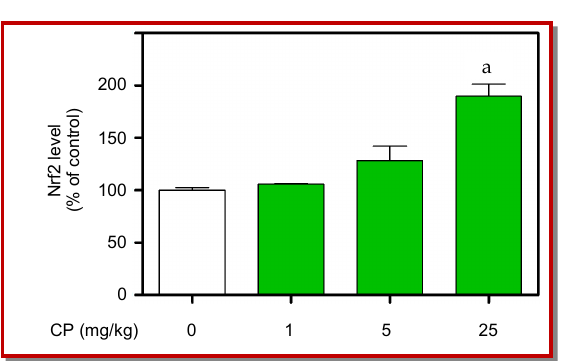
Figure 4: Effects of Cicadidae Periostracum (CP) on the nucle- ar factor E2-related factor 2 (Nrf2) level in the substantia nigra pars compacta. Nrf2 DNA-binding activity was measured using an enzyme-linked immunosorbent assay. a p<0.001 com- pared with the control group